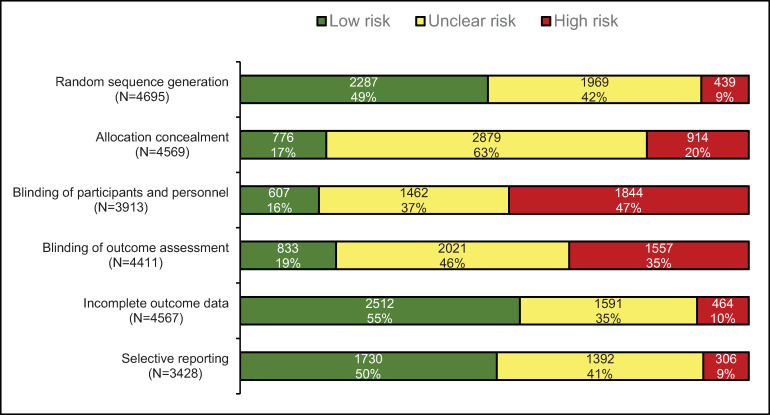
RoB for each domain in 4 715 RCTs on acupuncture.